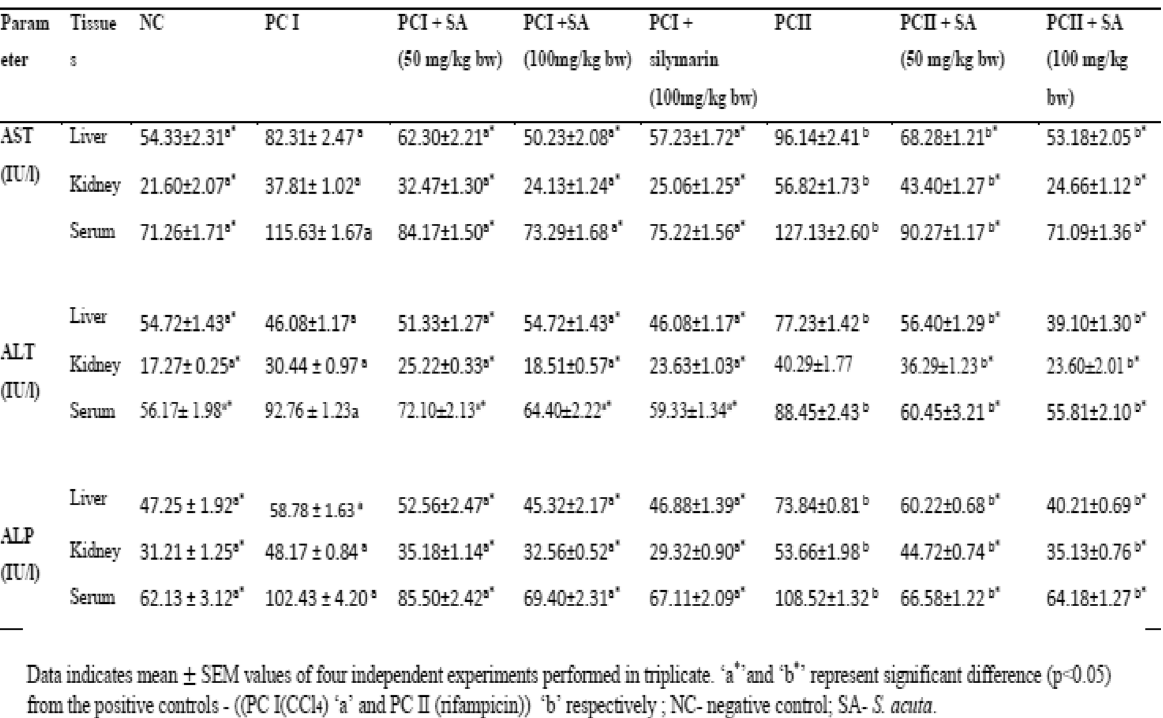
Table 3 Effect of S. acuta extract on heaptic and renal AST, ALT and ALP in rats exposed to CCI 4 and